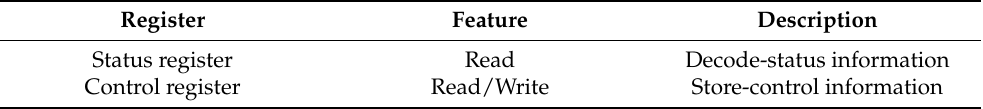
Table 1. The keyboard-register information.